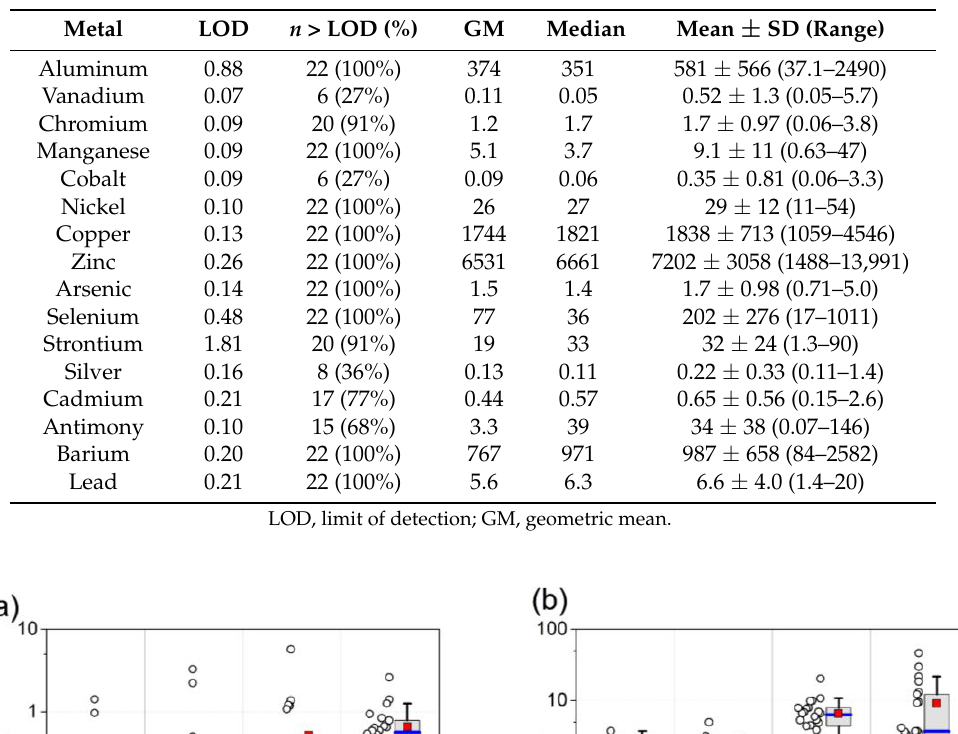
Table 3. Distribution of 16 metal compounds in the whole blood (µg/L) of 22 pregnant women attending a primarily Medicaid-serving prenatal clinic in Houston, Texas, 2015–2016.